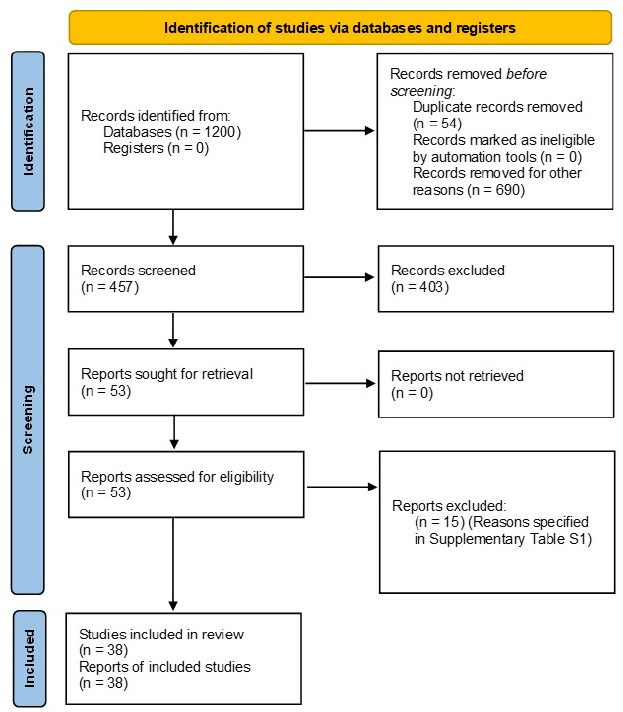
Figure 1. Prisma flow diagram of the search methodology employed for this review.